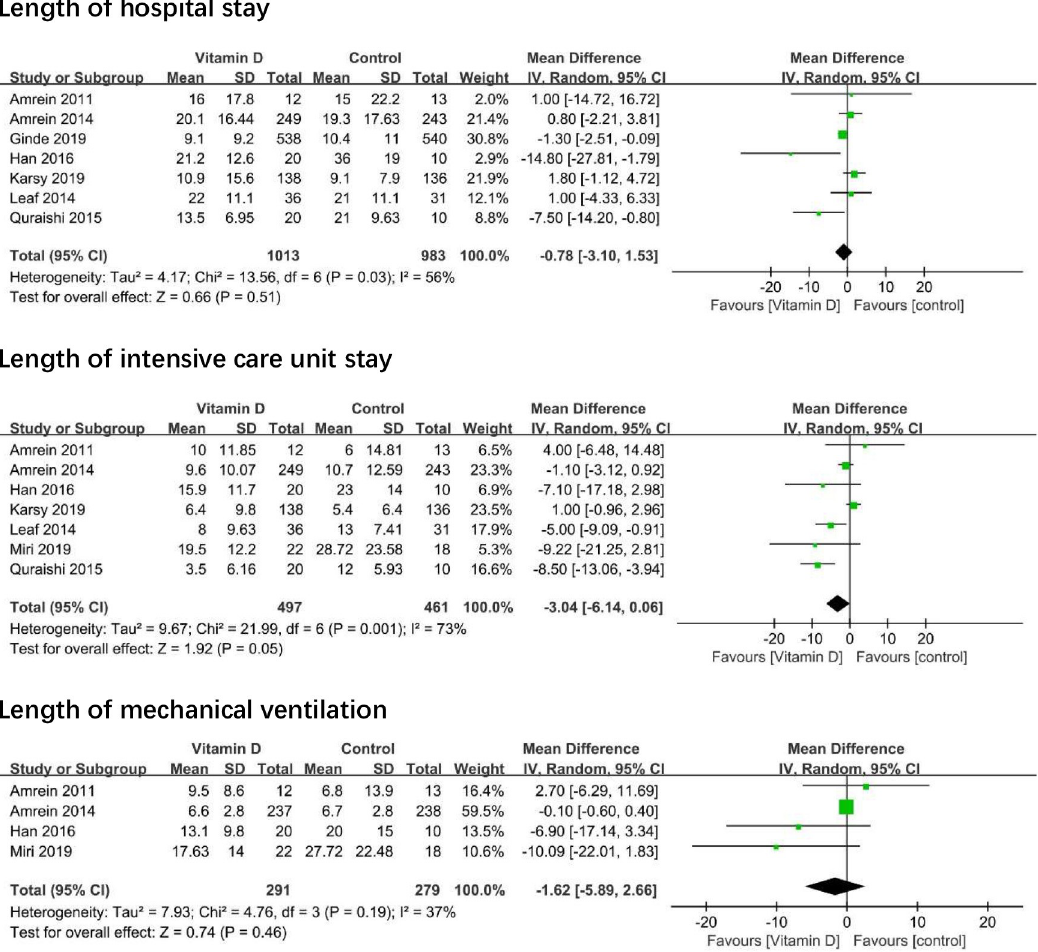
Fig 3. Association of vitamin D versus placebo with length of hospital stay, length of intensive care unit stay, and length of mechanical ventilation.